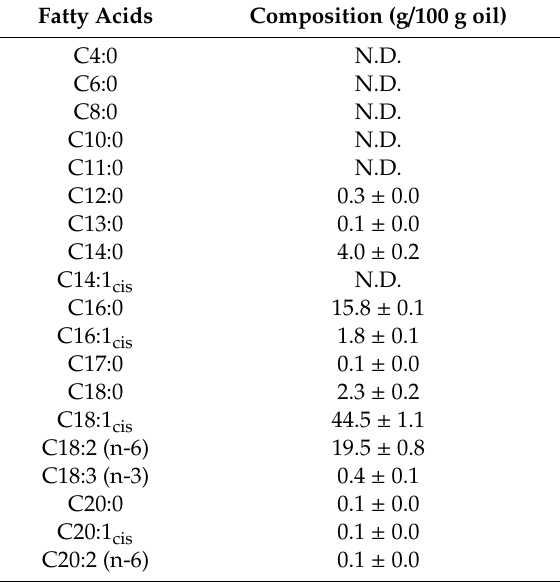
Table 3. Fatty acid composition of mealworm oil.